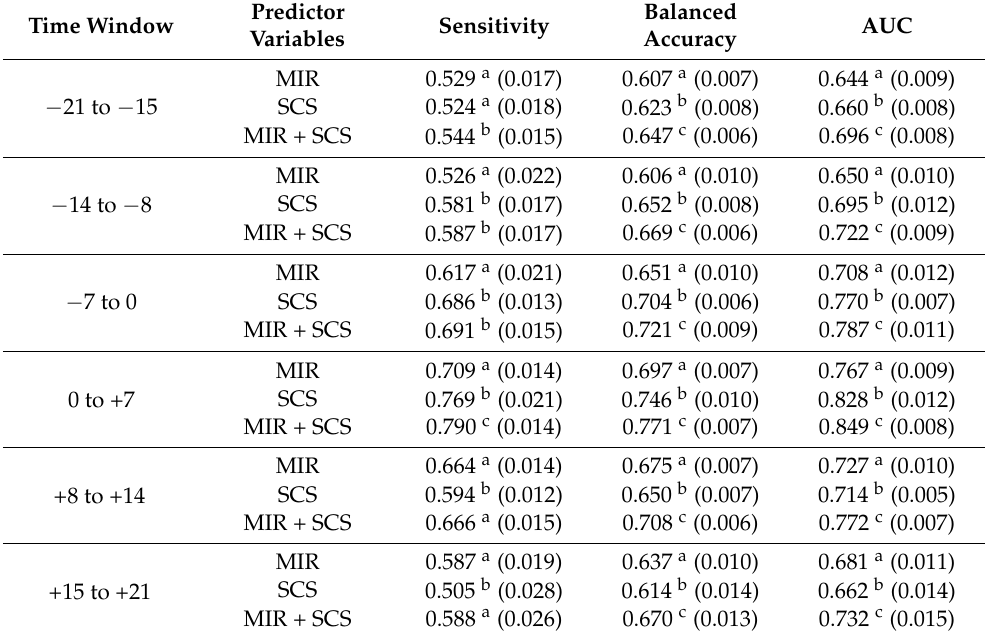
Table 4. Sensitivity, balanced accuracy and AUC (means of 10 independent runs, SD in parentheses) of different predictor variables in validation, split up for individual time windows before or after mastitis diagnosis. Balanced Predictor AUC Sensitivity Time Window Accuracy Variables − 21 to −